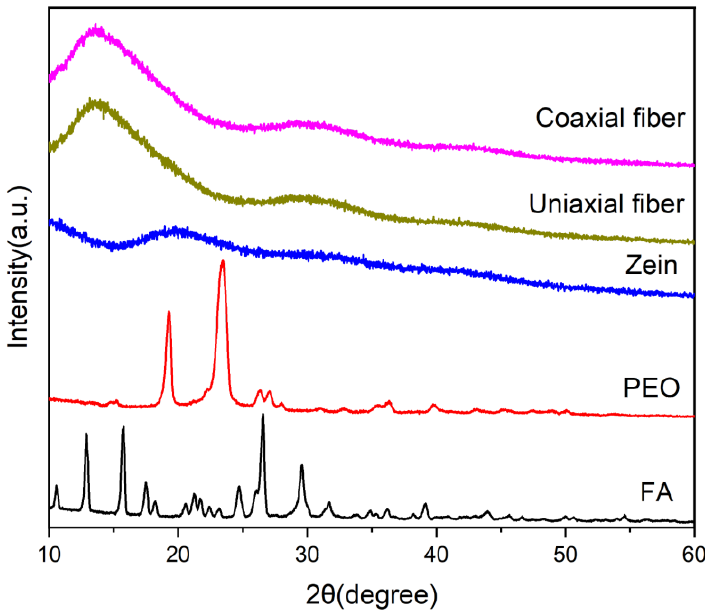
Figure 8. X-ray diffraction analysis of raw materials and electrospinning fibers.